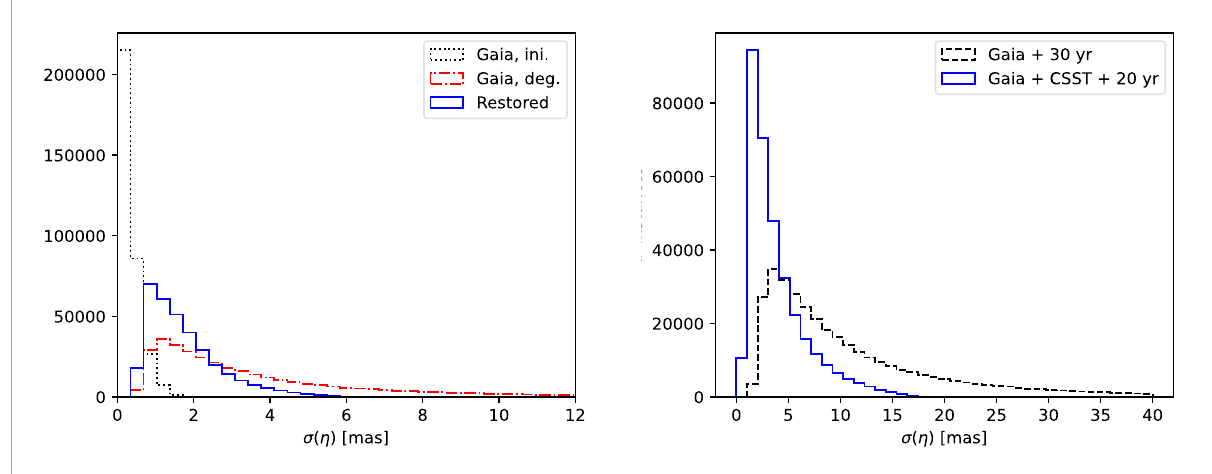
FIGURE 6 Left: position precision of Gaia, initial (dotted black line), degraded after 10 years (dashed-dotted red line), and partially restored with inclusion of CSST-OS measurements (solid blue line). Right: position precision of Gaia after 30 years, degraded without CSST-OS update (dashed black line) and mitigated with inclusion of CSST-OS measurements (solid blue line).